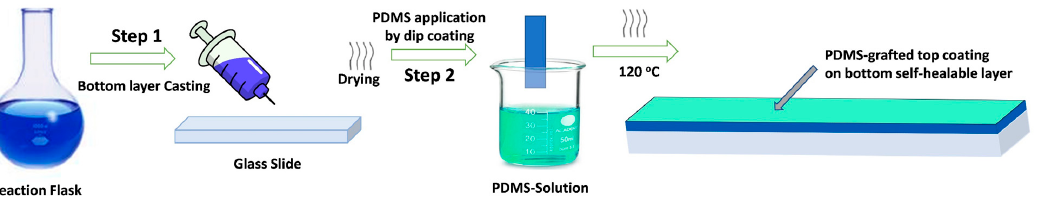
Figure 1. The chemistry of the self-healing PU (bottom layer) prior to modification with PDMS.